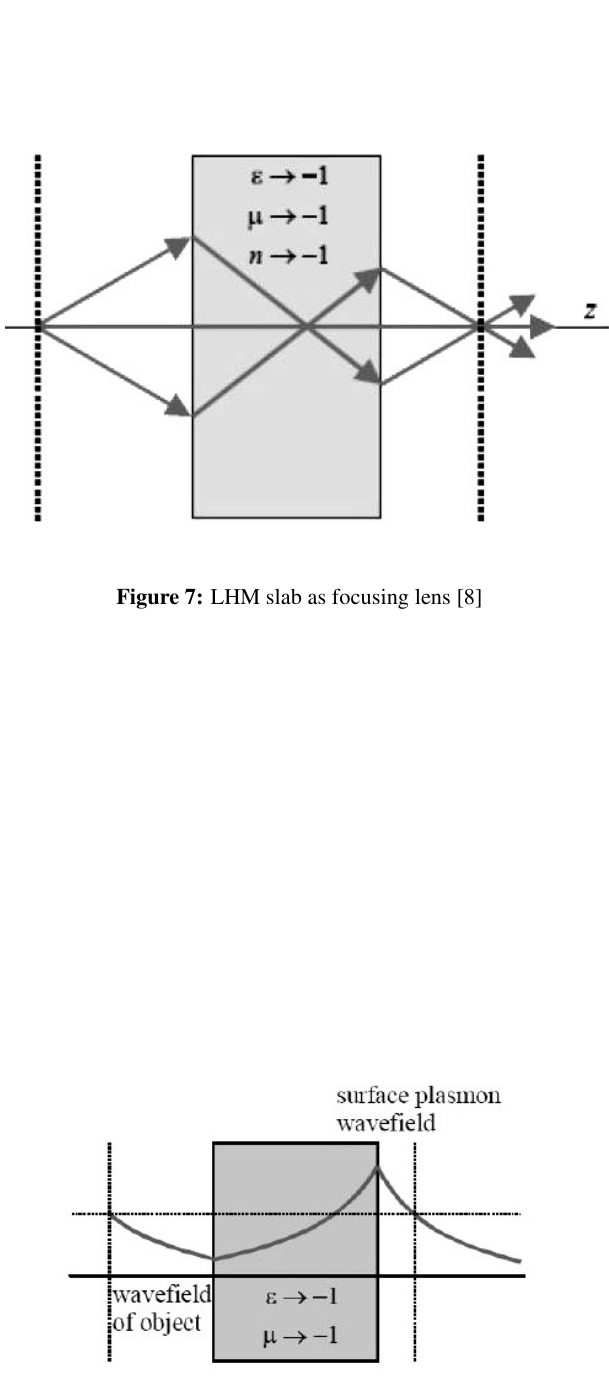
Figure 8: Near-field enhancement using a metamaterial